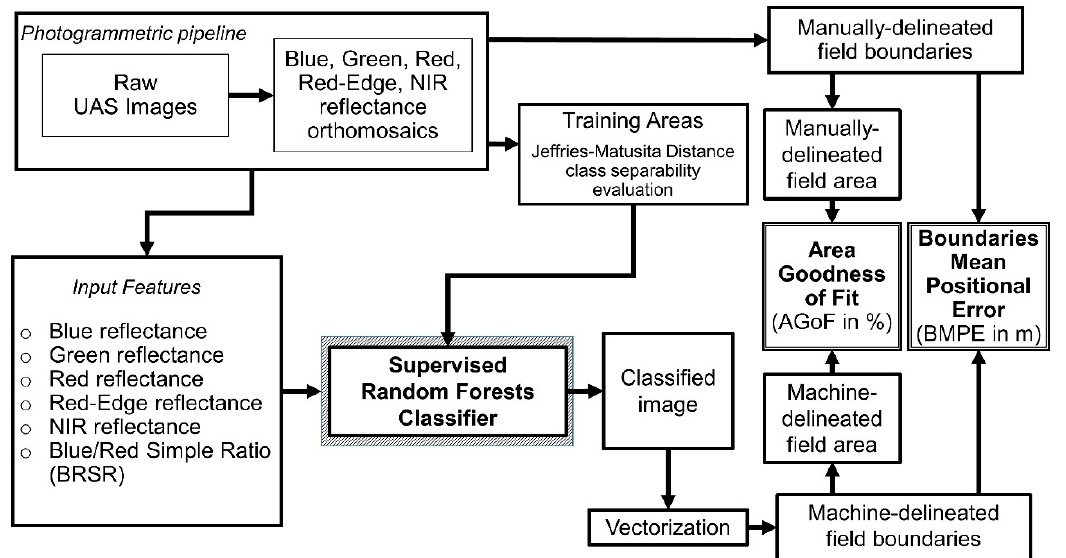
Figure 2. Flowchart of the pixel-based image analysis (PBIA) methodology.